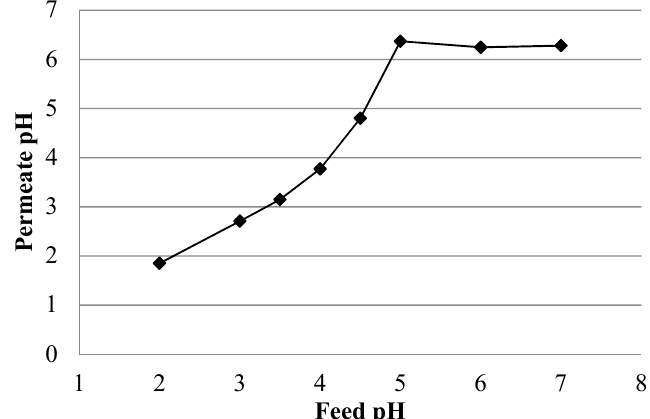
Figure 5. Permeate pH as a function of feed pH for Na 2 SO 4 and NaCl mixed salt solution.